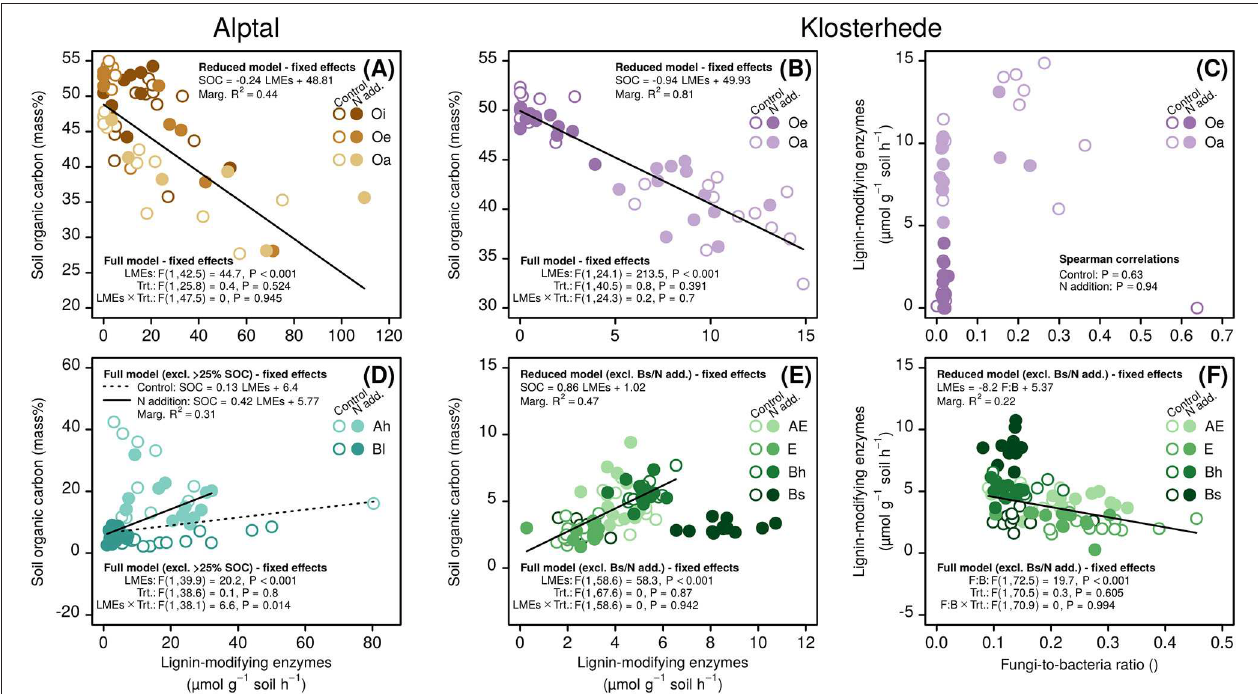
FIGURE 5 | Impact of N addition on relationships between the fungi-to-bacteria ratio, lignin-modifying enzymes and soil organic carbon at Alptal (A,D) and Klosterhede (B,C,E,F) . Relationships were assessed separately for organic (A–C) and mineral soil horizons (D–F) . Note that it was not possible to relate lignin-modifying enzymes to the fungi-to-bacteria ratio at Alptal due to data